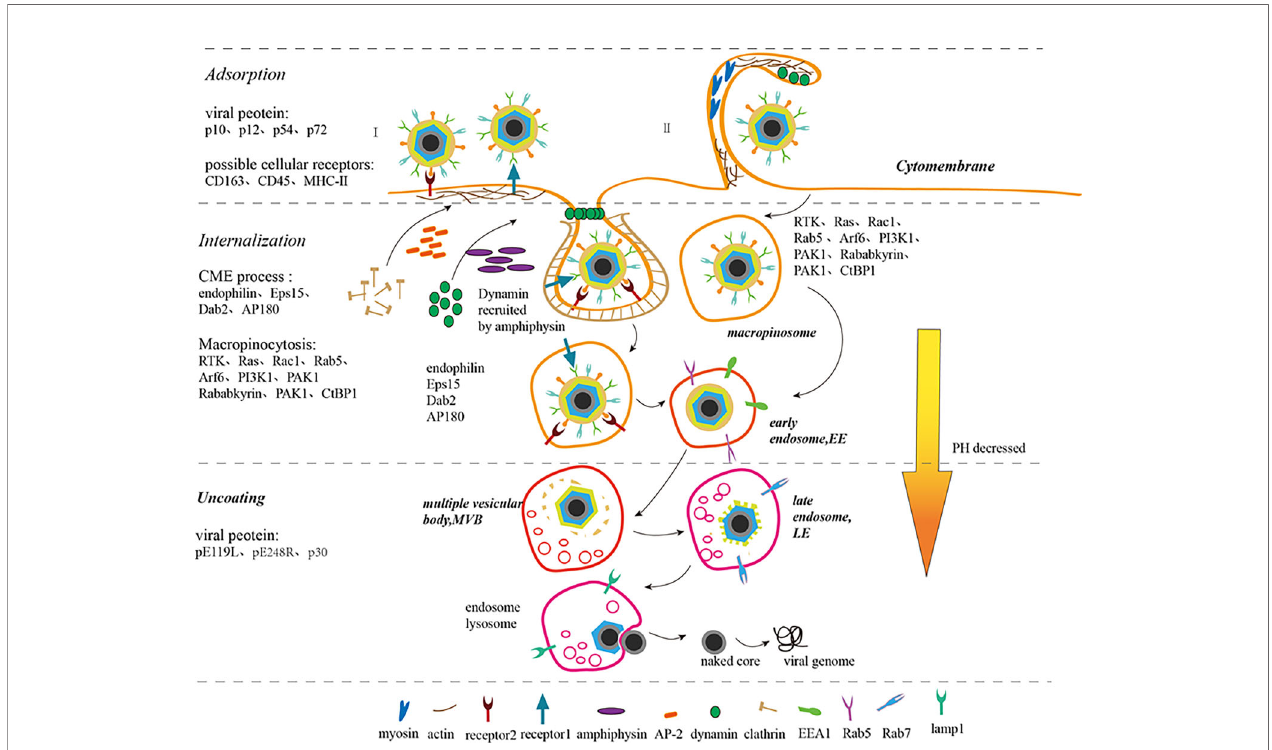
FIGURE 2 | ASFV adsorption, internalization, uncoating, and release process (7 – 9, 21 – 24). ASFV enters the host cell through endocytosis (I) and macropinocytosis (II). In endocytosis (I), the virus binds to the cell receptors to form coated pits. Adaptor protein-2 (AP-2) recruits clathrin to accumulate and assemble in coated pits and amphiphysin recruits dynamin simultaneously. Disabled protein 2 (Dab2), AP180, and Eps15-interacting protein (EPsin) can also recruit clathrin. The coated pits sink downward under the action of dynamin, endophilin, and actin. Simultaneously, dynamins assemble on the depressed neck and then cut the depressed corpuscles to separate it from the cell membrane. The separated small vesicles lose clathrin, thus forming early endosomes (EE). In micropinocytosis (II), the virions induce and activate RTK, Ras, Rac1, Rab5, Arf6, and PI3K1 signals, which activate actin, thus rearranging actin and micro fi laments to form ruf fl es or blebs on the cell membrane surface. PAK1 and Arf6 regulate the dynamic cytoskeletal changes and induce membrane bending. Rab5, Rababkyrin, PAK1 and CtBP1 induce ruf fl e closure. Myosin provides contractile activity for ruf fl e closure. The macropinosomes are equivalent to the EEs of the cell. EEs migrate, mature and are acidi fi ed within the cell to form multiple vesicular bodies (MVBs), late endosome (LE), and endosome lysosome gradually. ASFV sheds its capsid in LE, fuses its inner capsule with the restricted endosome membrane, releases its core shell into the cytoplasm, and then releases its